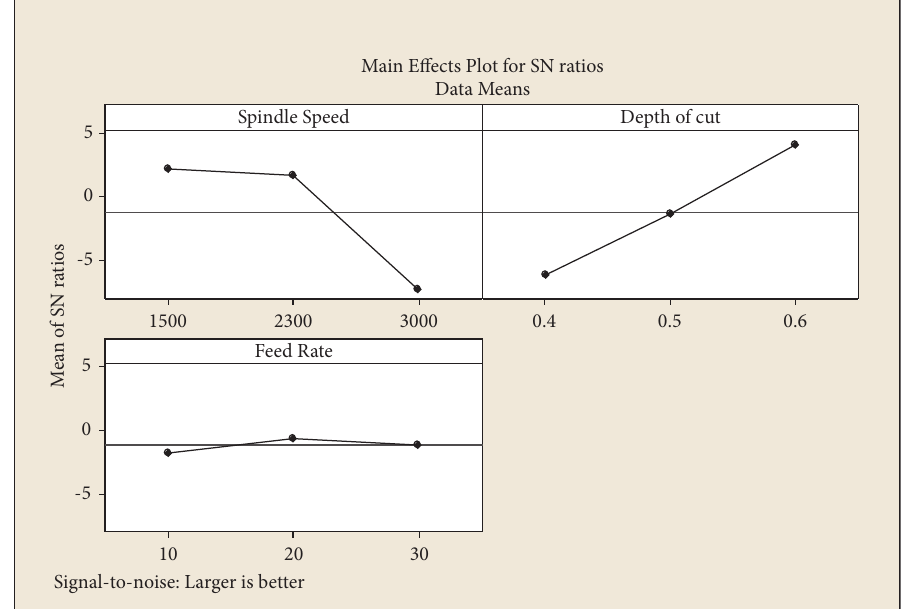
Figure 6: S/N ratio plot for MRR-dry runs.